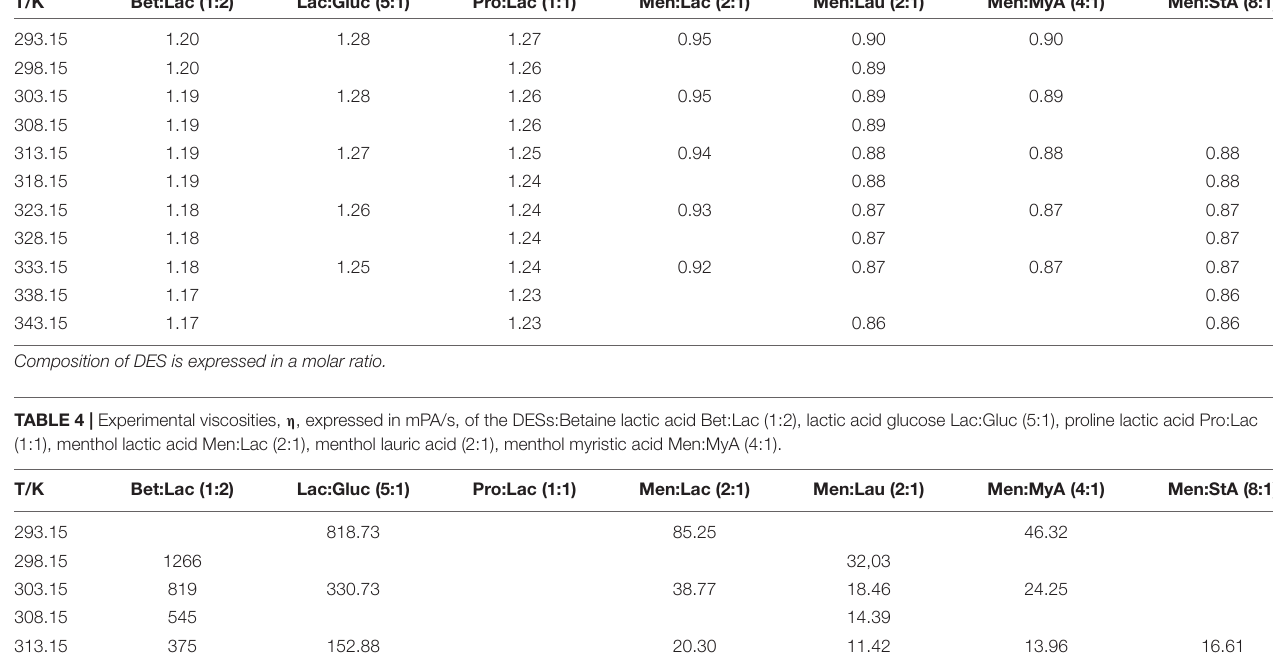
CBD + CBDA/g hemp.